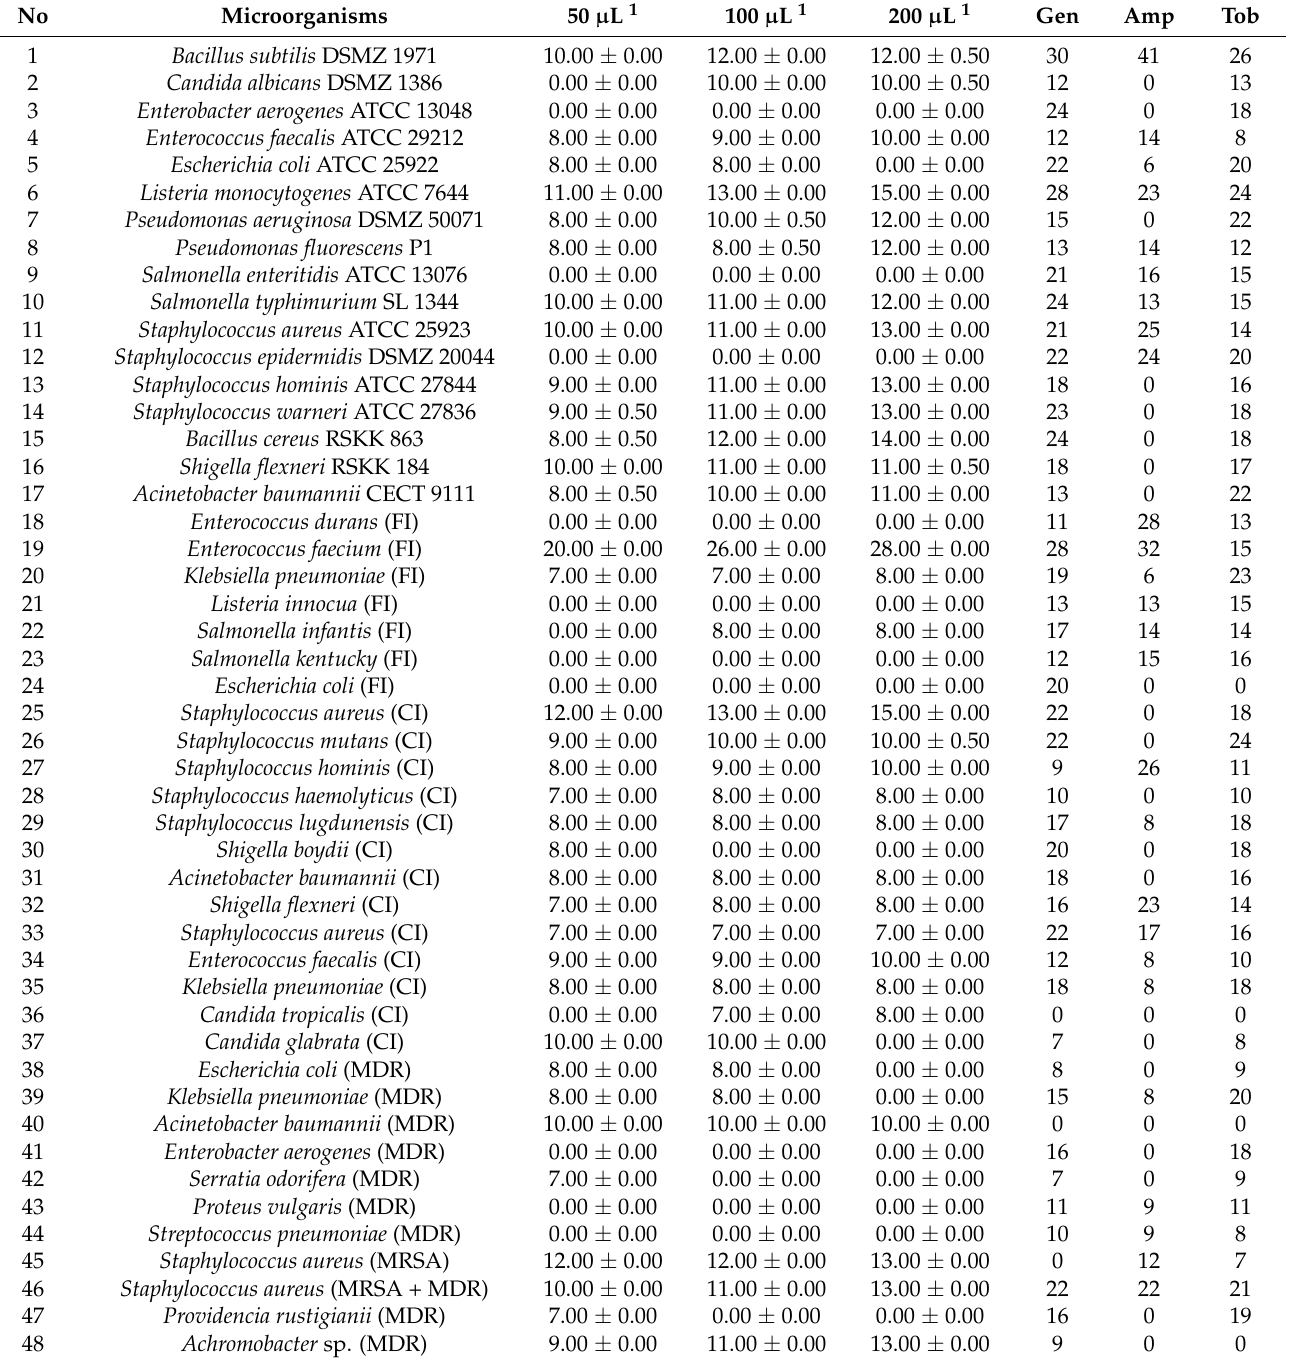
Table 1. Disk diffusion test results of AFEt (inhibition zone diameters in